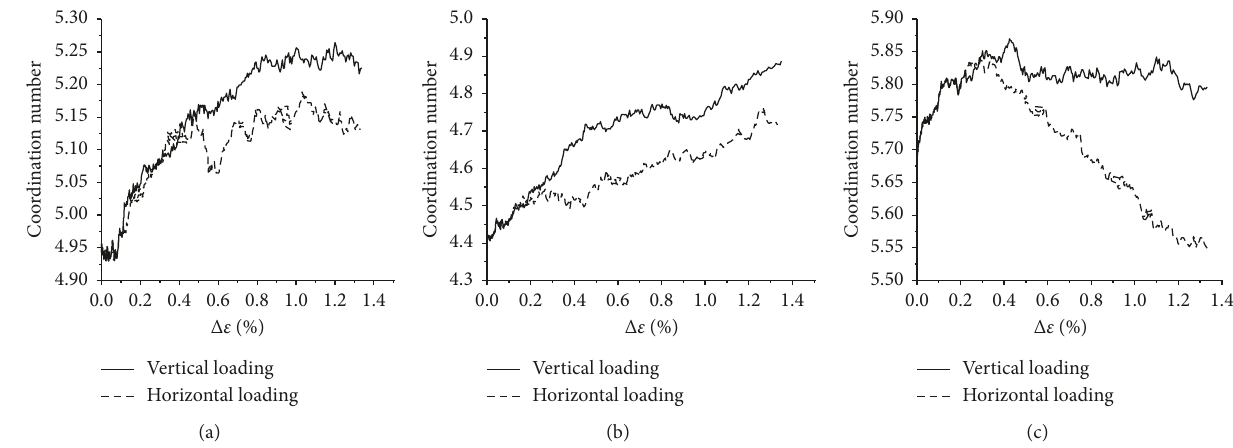
Figure 9: Curves of coordination numbers: (a) sample group A; (b) sample group B; (c) sample group C.